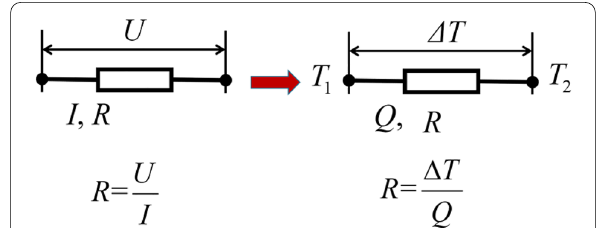
Figure 2 Popularization principle of thermal resistance